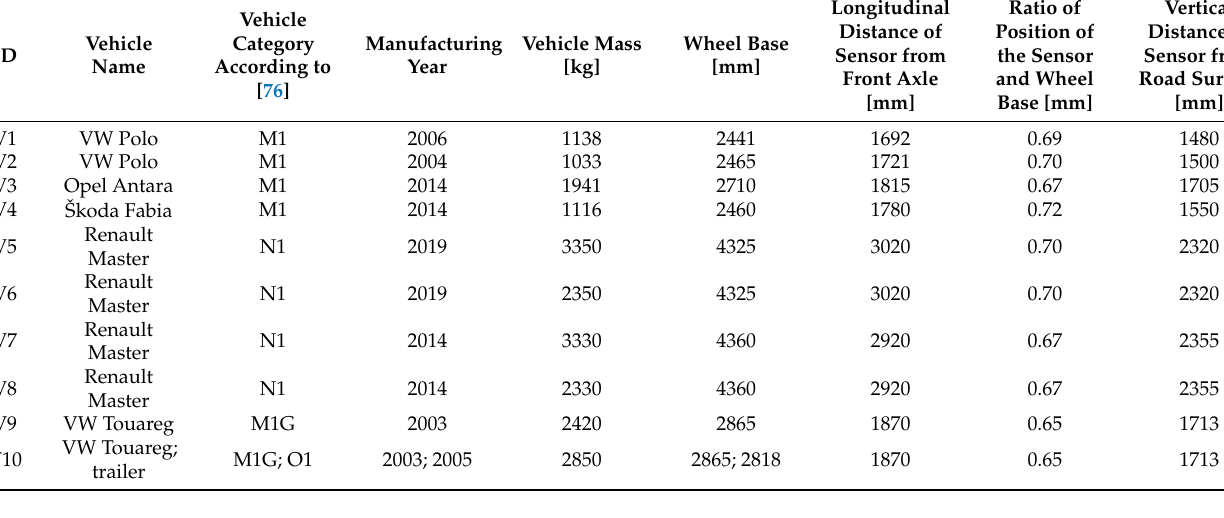
Figure 6. Scheme of test setup installation. Table 3. Selected parameters of vehicles used in tests.